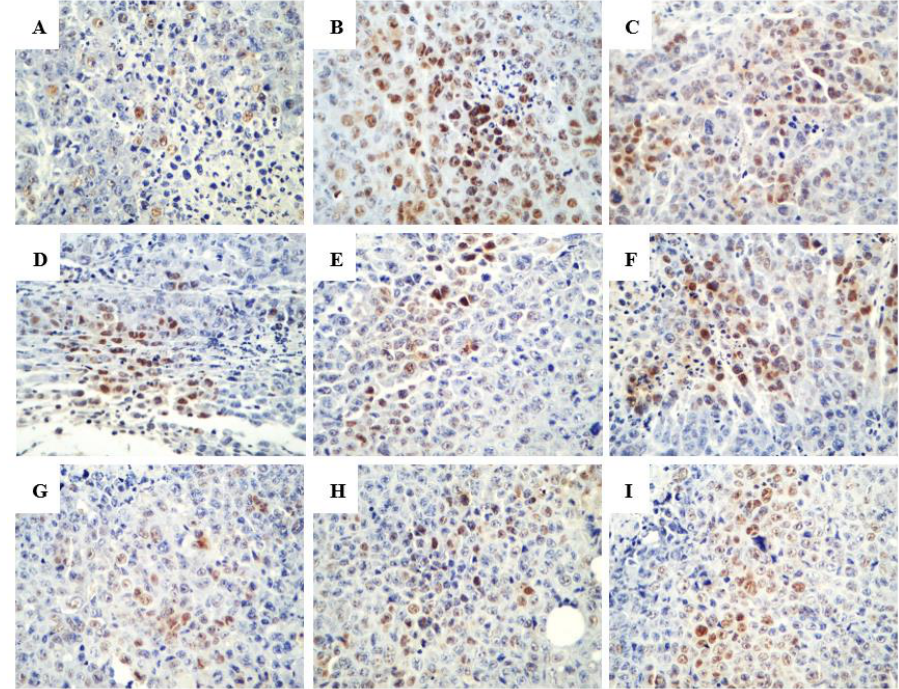
Figure 6. Representative histologic examination of morphological changes in tumors from H22-tumor bearing mice. Tumor sections were analyzed by the TUNEL assay to indicate cell apoptosis (400 × ). ( A ) model control, ( B ) CTX, ( C ) Rh 2 -H, ( D ) R-PHQ-L, ( E ) R-PHQ-M, ( F ) R-PHQ-H, ( G ) S-PHQ-L, ( H ) S-PHQ-M, ( I ) S-PHQ-H.